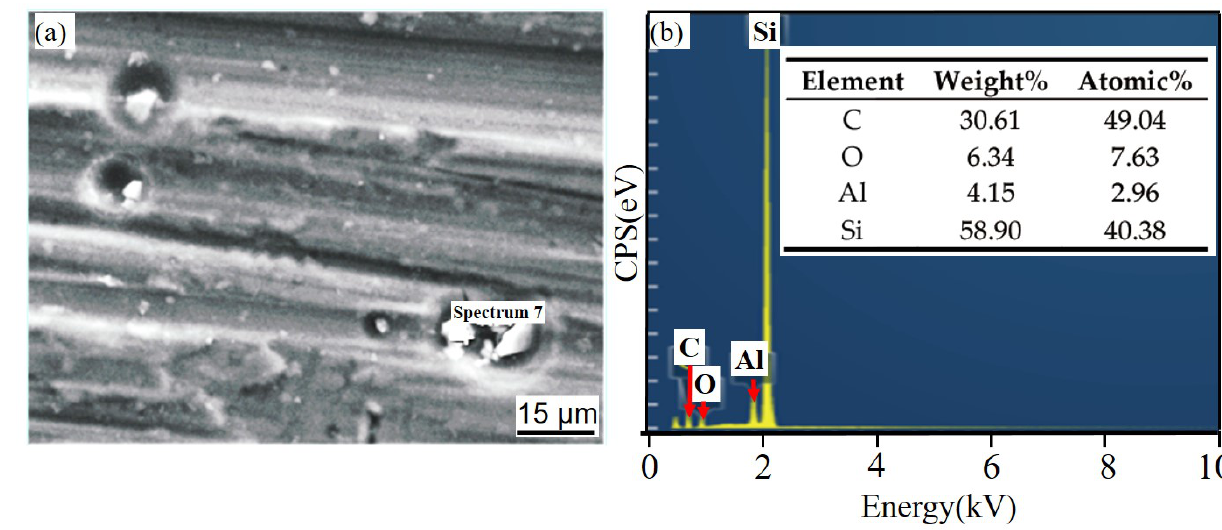
Figure 21. EDS of corrosion products in corrosion pits of 6061Al alloy after SL for 21 days. ( a ) SEM image of corrosion products; ( b ) EDS of corrosion products.